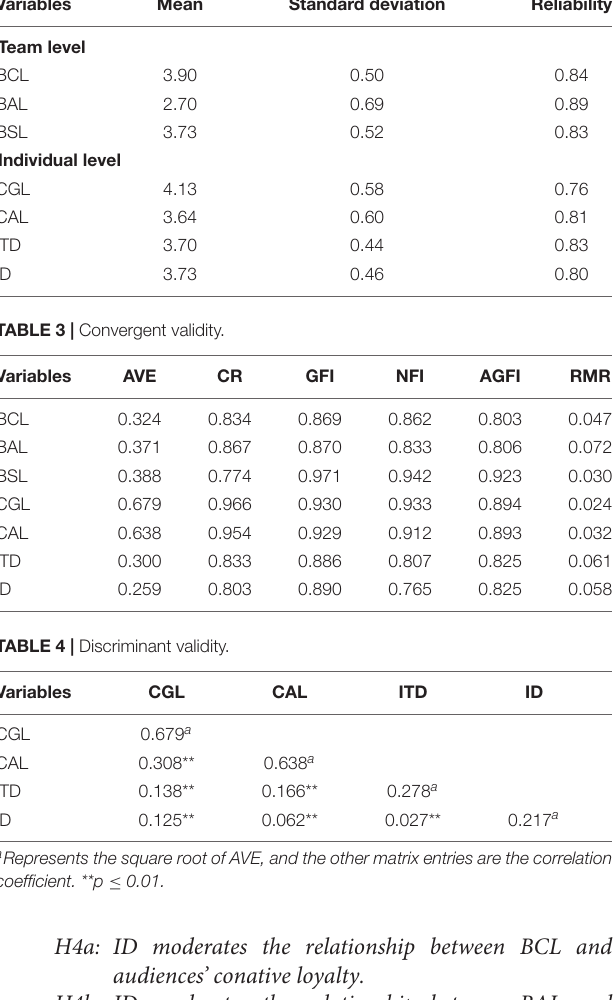
TABLE 2 | Descriptive statistics of the variables. Variables